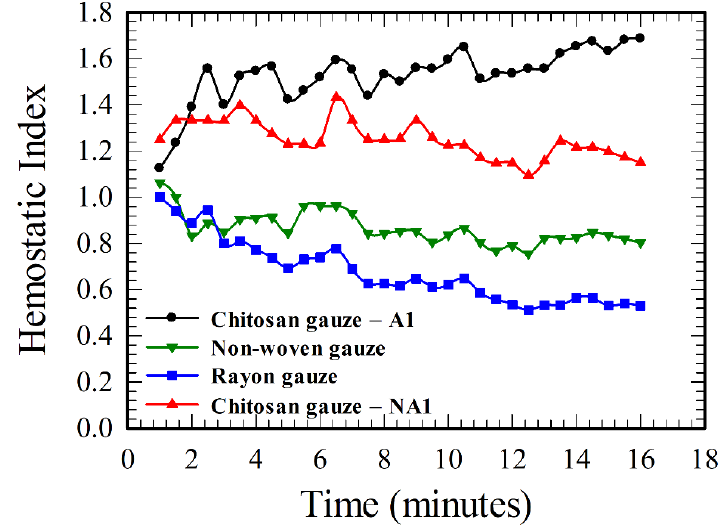
Figure 6. Comparison of the hemostatic indexes for different gauzes.